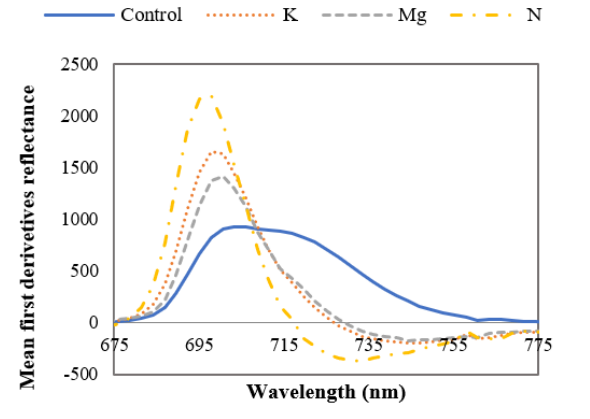
Figure 8. Mean first derivative spectra of control and nutrient-deficient leaves between ~675 nm and ~775 nm, showing the difference between curve shapes of control and nutrient-deficient leaves.